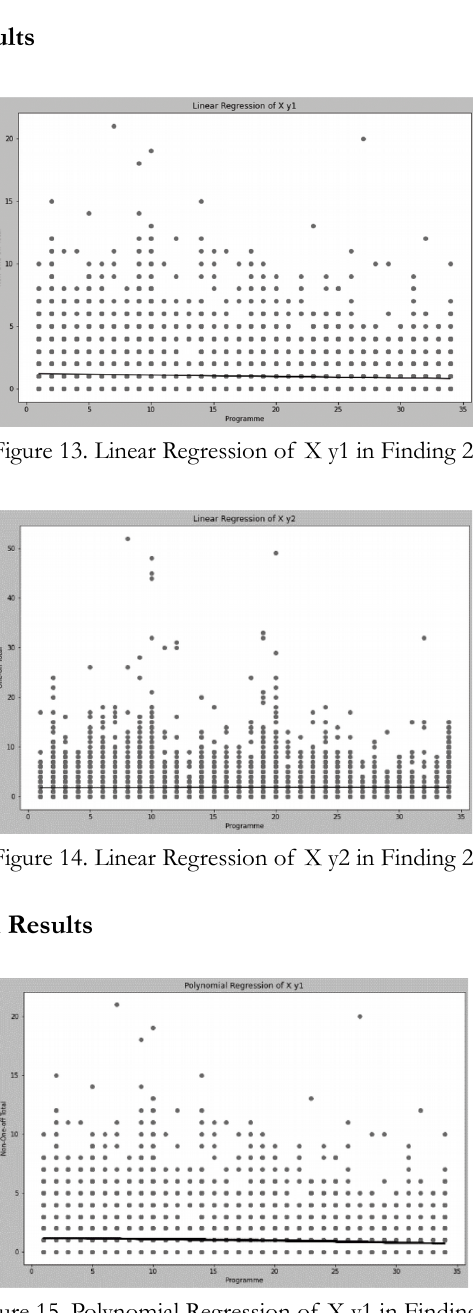
Figure 15. Polynomial Regression of X y1 in Finding